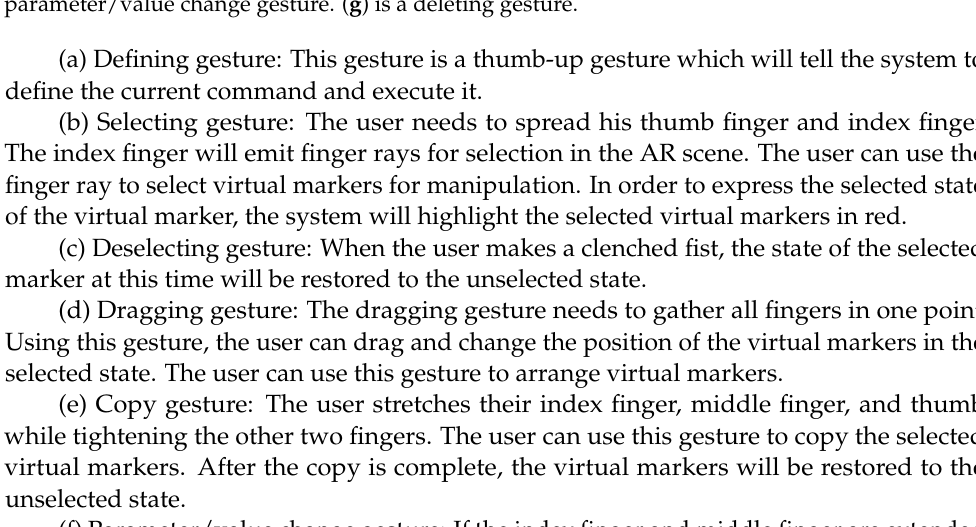
Figure 5. Hand gestures can be used to control virtual markers. ( a ) is a defining gesture. ( b ) is a selecting gesture. ( c ) is deselecting gesture. ( d ) is a dragging gesture. ( e ) is a copy gesture. ( f ) is a parameter/value change gesture. ( g ) is a deleting